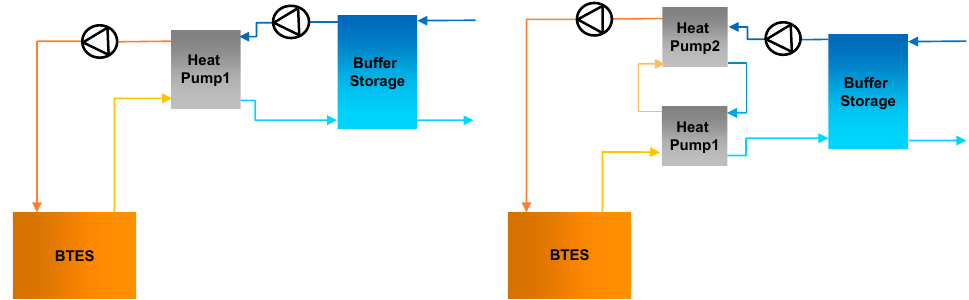
Figure 2. System layouts of the active cooling scenarios: ActPar (left) and ActSer (right).